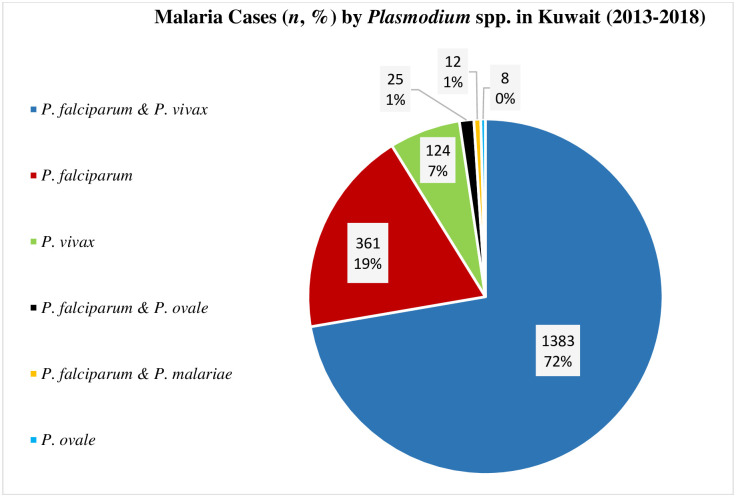
A pie chart showing the share (n, %) of reported malaria cases infected with different species of malaria in Kuwait (2013–2018), mixed infection with P. falciparum and P. vivax constituting the major infection type.